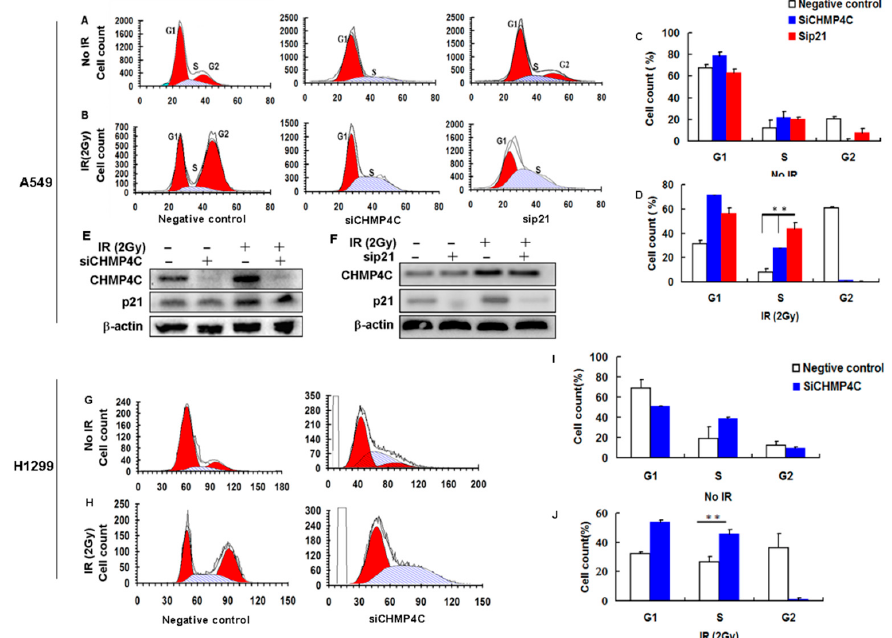
Figure 2. CHMP4C silencing delayed S-phase of the cell cycle. ( A , B ) A549 cells were transfected with negative control, siCHMP4C or sip21 for 24 h and/or exposed to 2 Gy IR. After 24 h, the cells were stained with Vibrant Dyecycle green stain and tested on a flow cytometer; ( C , D ) Cell cycle analyses of A549 cells. The data are presented as the mean ± S.E. of three independent experiments, ** p < 0.01; ( E , F ) Western blot analysis of Expression of CHMP4C and P21 after CHMP4C or p21 silencing with or without IR (2 Gy); ( G , H ) H1299 cells were transfected with negative control or siCHMP4C for 24 h and/or exposed to 2 Gy IR; After 24 h, the cells were stained with Vibrant Dyecycle green stain and analyzed on a flow cytometer; ( I , J ) Cell cycle analyses of H1299 cells. The data are presented as the mean ± S.E. of three independent experiments, ** p < 0.01.